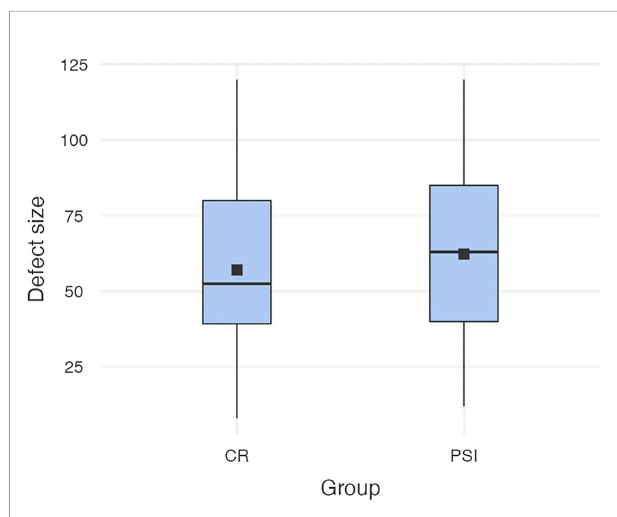
FIGURE 2 | Defect sizes in both groups (conventional reconstruction plates vs . patient-speci fi c